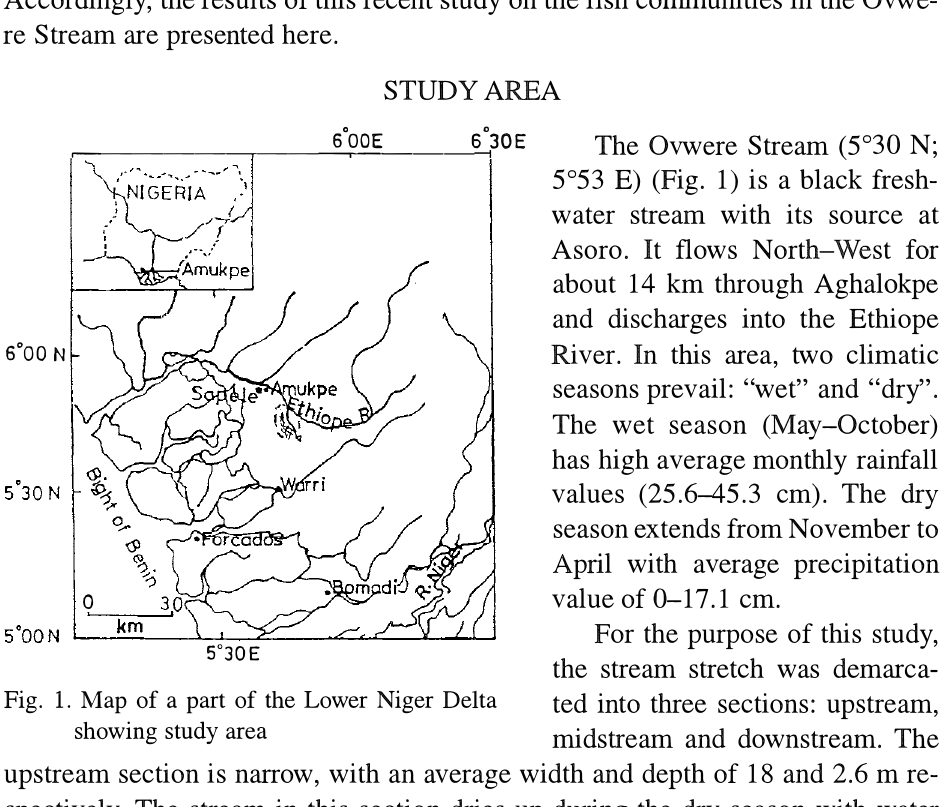
Fig. 1. Map of a part of the Lower Niger Delta ted into three sections: upstream, showing study area midstream and downstream.